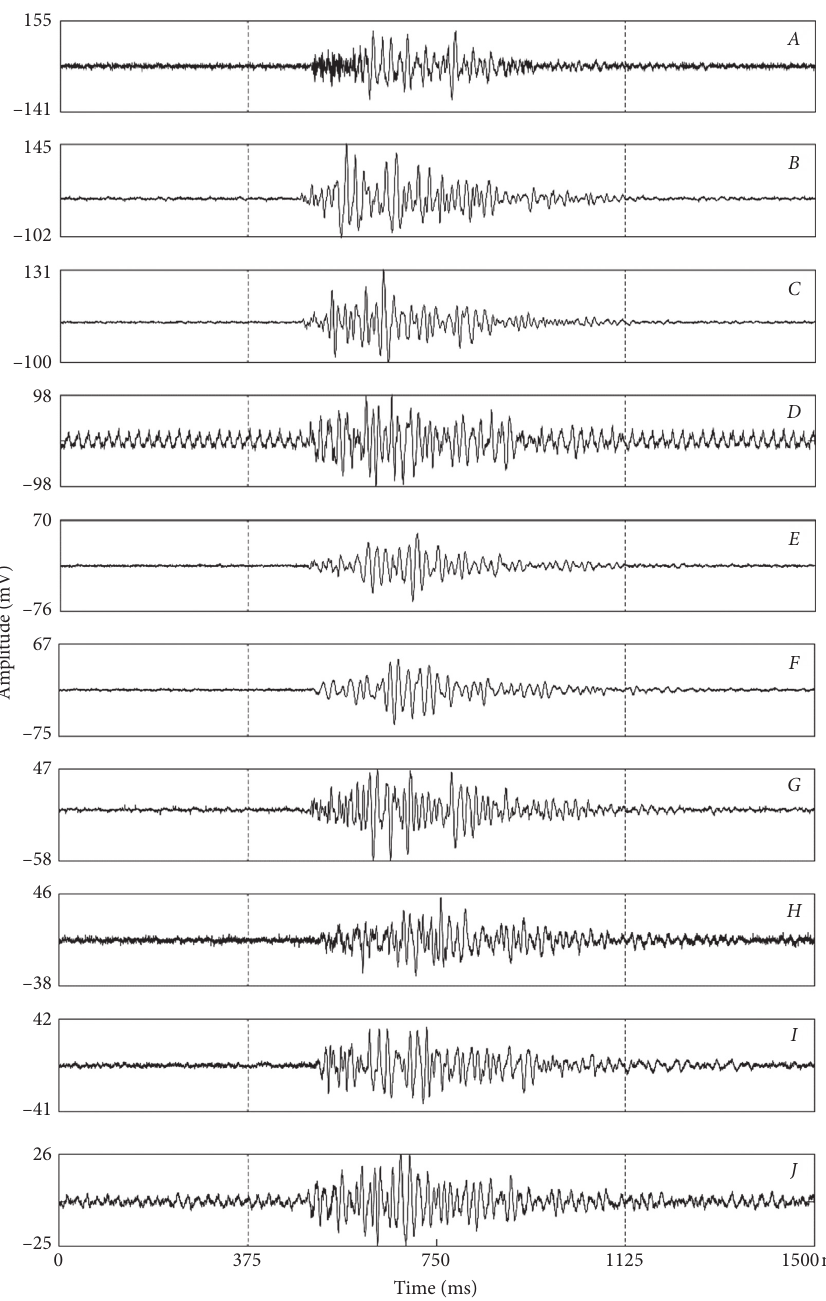
Figure 12: MS waveforms with background